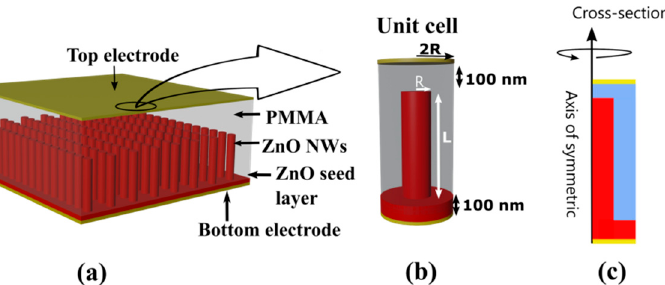
Figure 1. ( a ) Structure of the VING device; ( b ) unit cell of the VING and ( c ) cross section of the VING unit cell around the axis of symmetry.